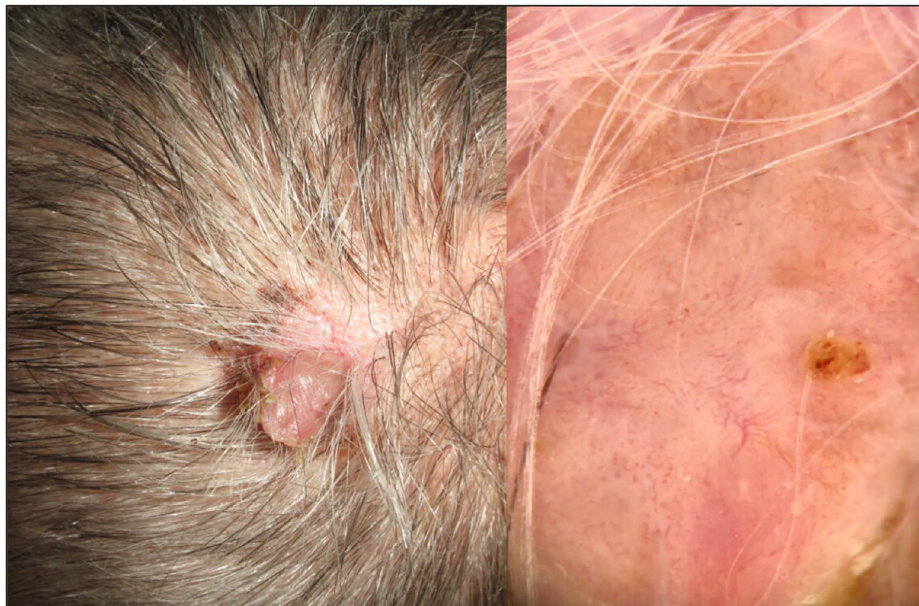
Figure 5. ( A ) Clinical image of a 74-years-old man with an amelanotic papule in the scalp vertex; ( B ) Dermoscopic image of the lesion showing polymorphous vessels and ulceration. Histopathological examination showed a nodular melanoma with a Breslow thickness of 5.5 mm.